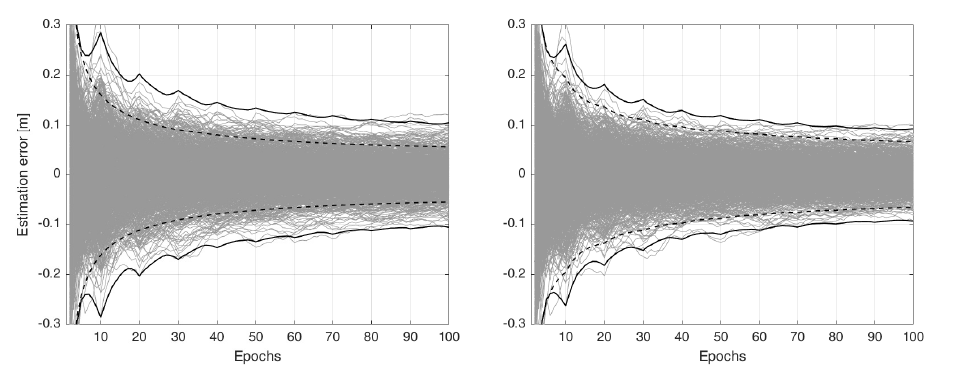
ˆ b = 1, . . . ,100) of Example 1 h h ( h − |